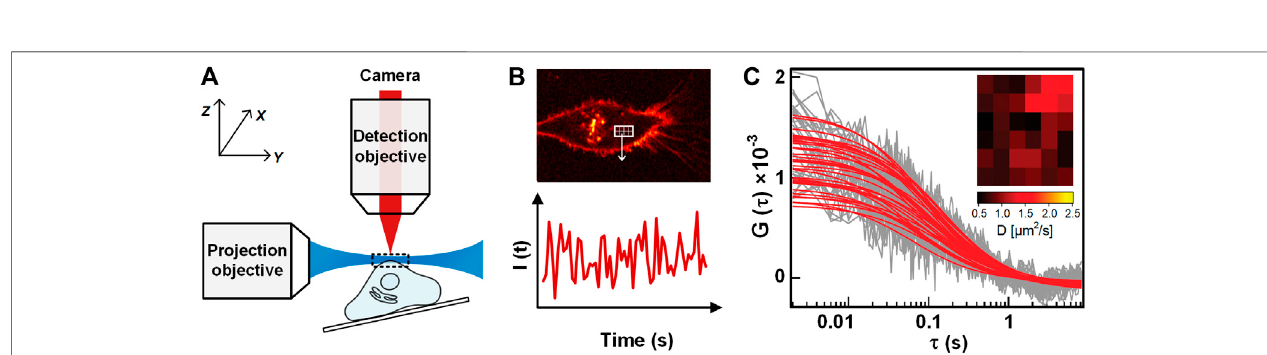
FIGURE 8 | Illustration of SPIM-FCS. ( A ) Schematic of SPIM-FCS measurement on a sample. ( B ) The sectioned image of the sample when illuminated by a light sheet (Top), and the fl uorescence intensity trace from one pixel in the image series (Bottom). ( C ) The ACFs of different pixels/locations. The Inset shows the Diffusion coef fi cient map. Adapted from Ref.